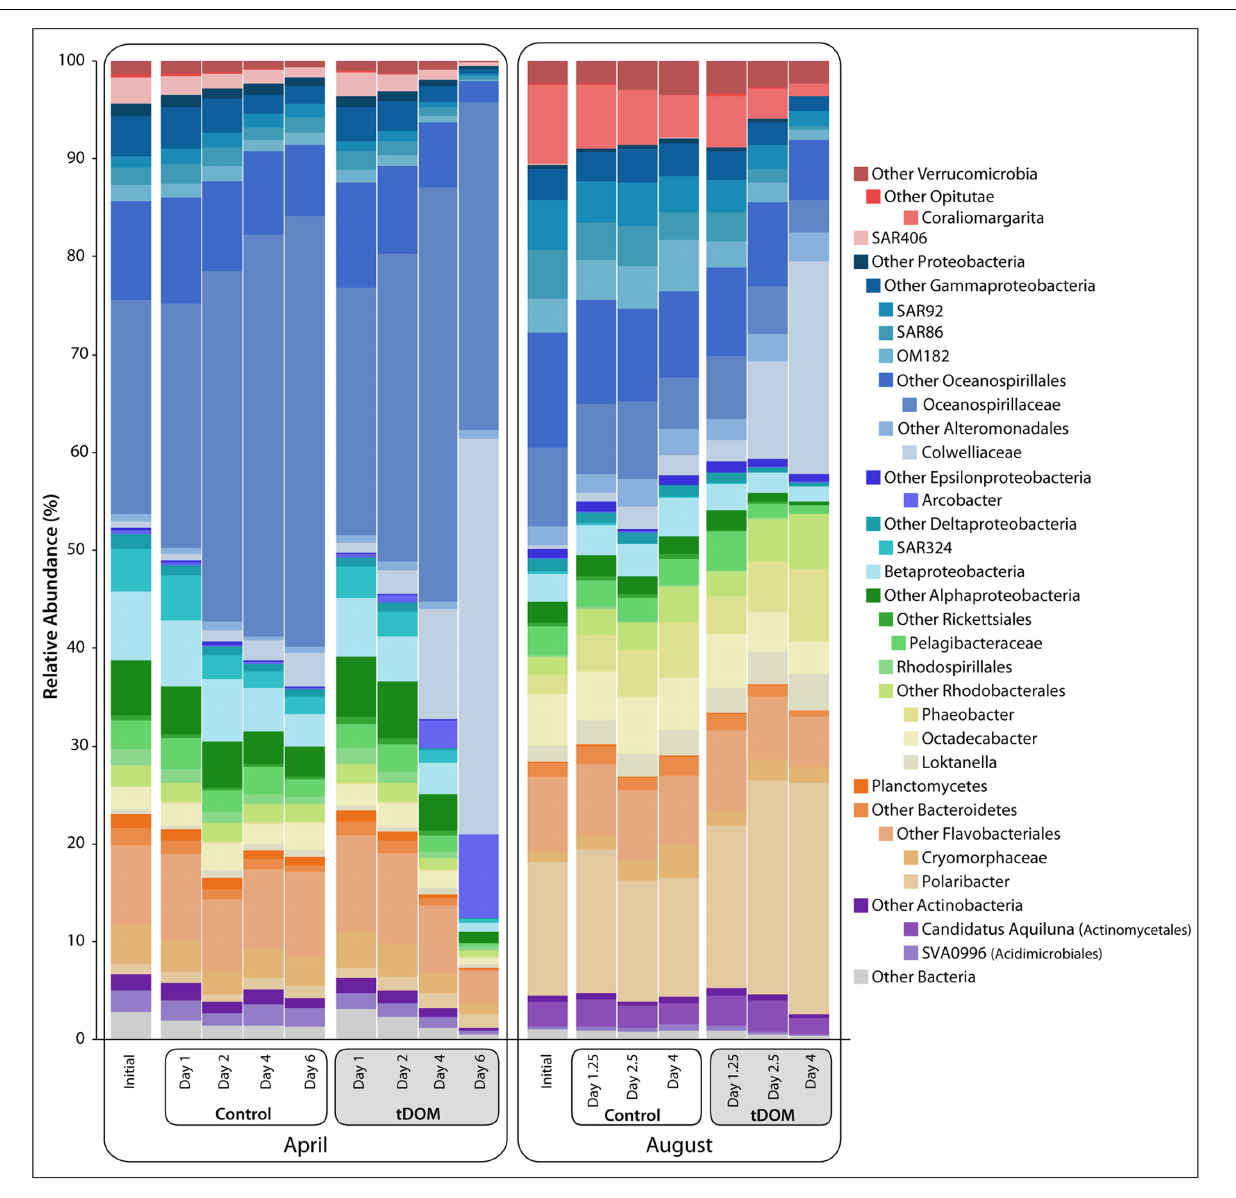
FIGURE 2 | Bacterial relative abundance with tDOM additions. Stacked bar chart of bacterial taxonomy throughout the course of the bioassays [Controls and treatments with additions of terrestrial-derived dissolved organic matter (tDOM)]. Taxonomy was assigned in QIIME (v. 1.8) using the RDP classifier (Caporaso et al., 2010) based on DNA sequences, randomly subsampled to 3037 sequences per sample, from the v4 region of the 16S rRNA gene. Major bacterial phyla are further broken down into more specific taxonomic ranks (class or order) to highlight the dynamics of these taxa throughout the